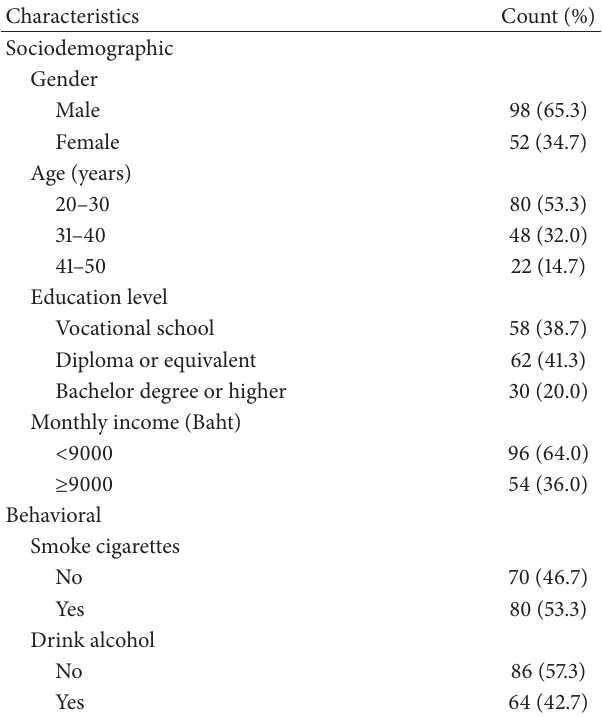
Table 1: Frequency distributions of general characteristics of the subjects ( 𝑛 =